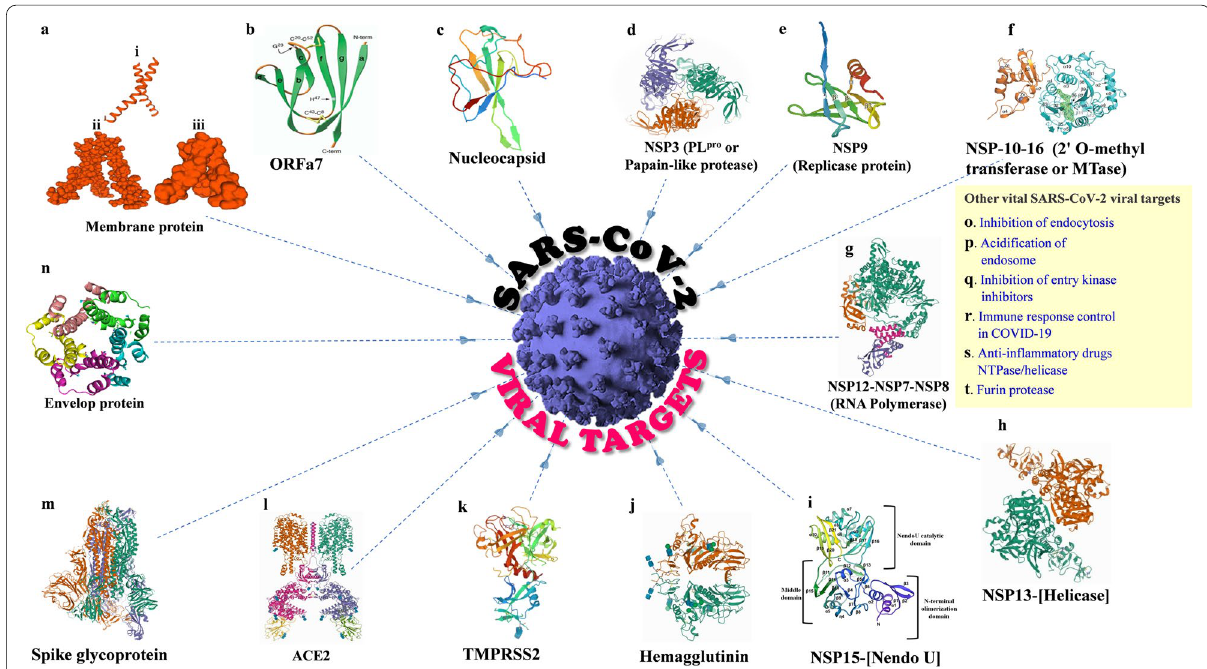
Fig. 6 Typical viral targets against SARS-CoV-2 including a Membrane protein (i, ii, iii); b ORFa7; c Nucleocapsid; d (NSP9 (Replicase protein)); e NSP3 (PL. pro or Papain-like protease); f NSP-10–16 (2’ O-methyltransferase or MTase); g NSP12-NSP7-NSP8 (RNA Polymerase); h NSP13-[Helicase]; i NSP15-[Nendo U]; j Hemagglutinin; k TMPRSS2 (Transmembrane serine protease 2); l ACE2 (Angiotensin-Converting Enzyme 2); m Spike glycoprotein (highly immunogenic); n Envelop protein; In addition to that the other important SARS-CoV-2 viral targets are influenced as o Inhibition of endocytosis; p Acidification of endosome; q Inhibition of entry kinase inhibitors; r Immune response control in COVID-19; s Anti-inflammatory drugs NTPase/Helicase and t Furin